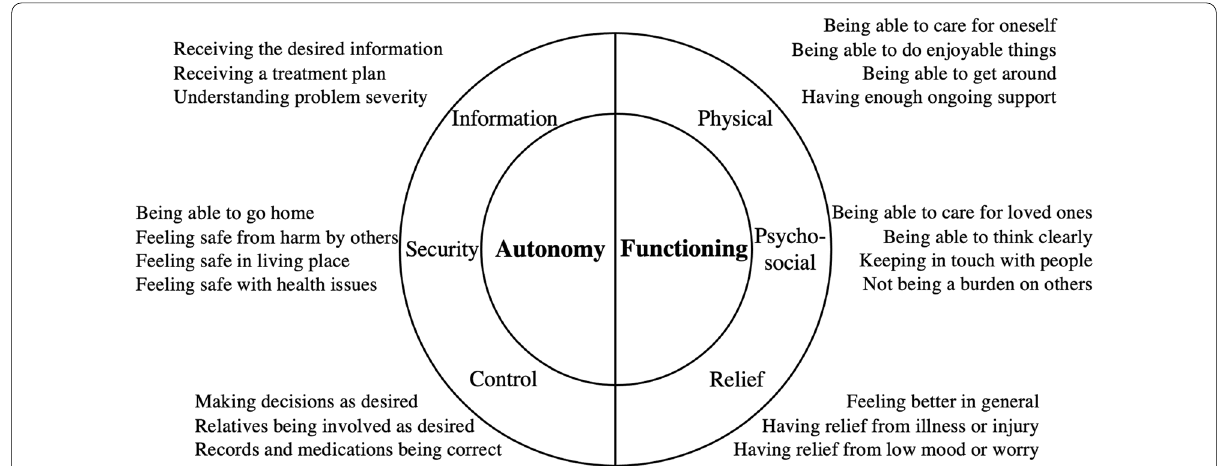
Fig. 1 Acute healthcare outcome goals for older people living with frailty classified in qualitative research